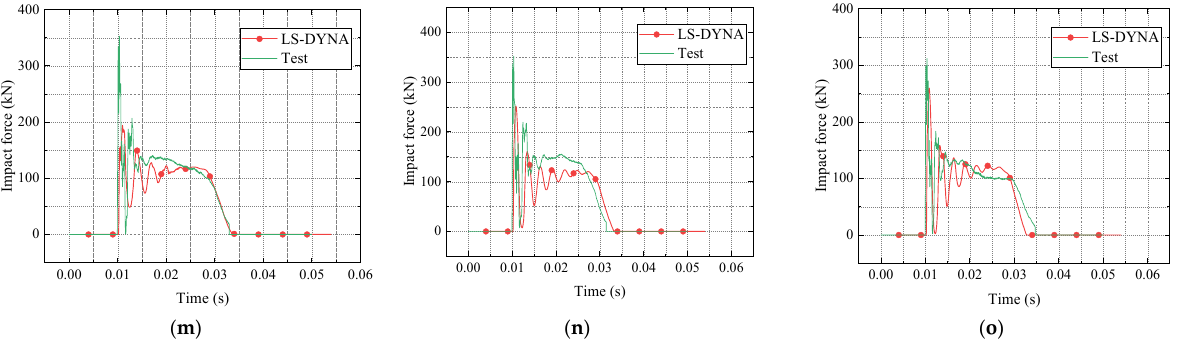
Figure 5. Impact force–time history curve. ( a ) RC; ( b ) RC0.3; ( c ) RC0.5; ( d ) H-DS; ( e ) H-DS0.3; ( f ) H-DS0.5; ( g ) S-ST; ( h ) S-ST0.3; ( i ) S-ST0.5; ( j ) R-ST; ( k ) R-ST0.3; ( l ) R-ST0.5; ( m ) S-DS; ( n ) S-DS0.3; ( o ) S-DS0.5. Figure 6 shows the comparison of predicted and measured mid-span displacement– time histories of five column specimens with different cross sections. It can be seen that, consistent with the impact force–time history curves, the mid-span displacement of the simulated RC column deviates from the test result due to the limited capacity in simulating severe concrete damage.